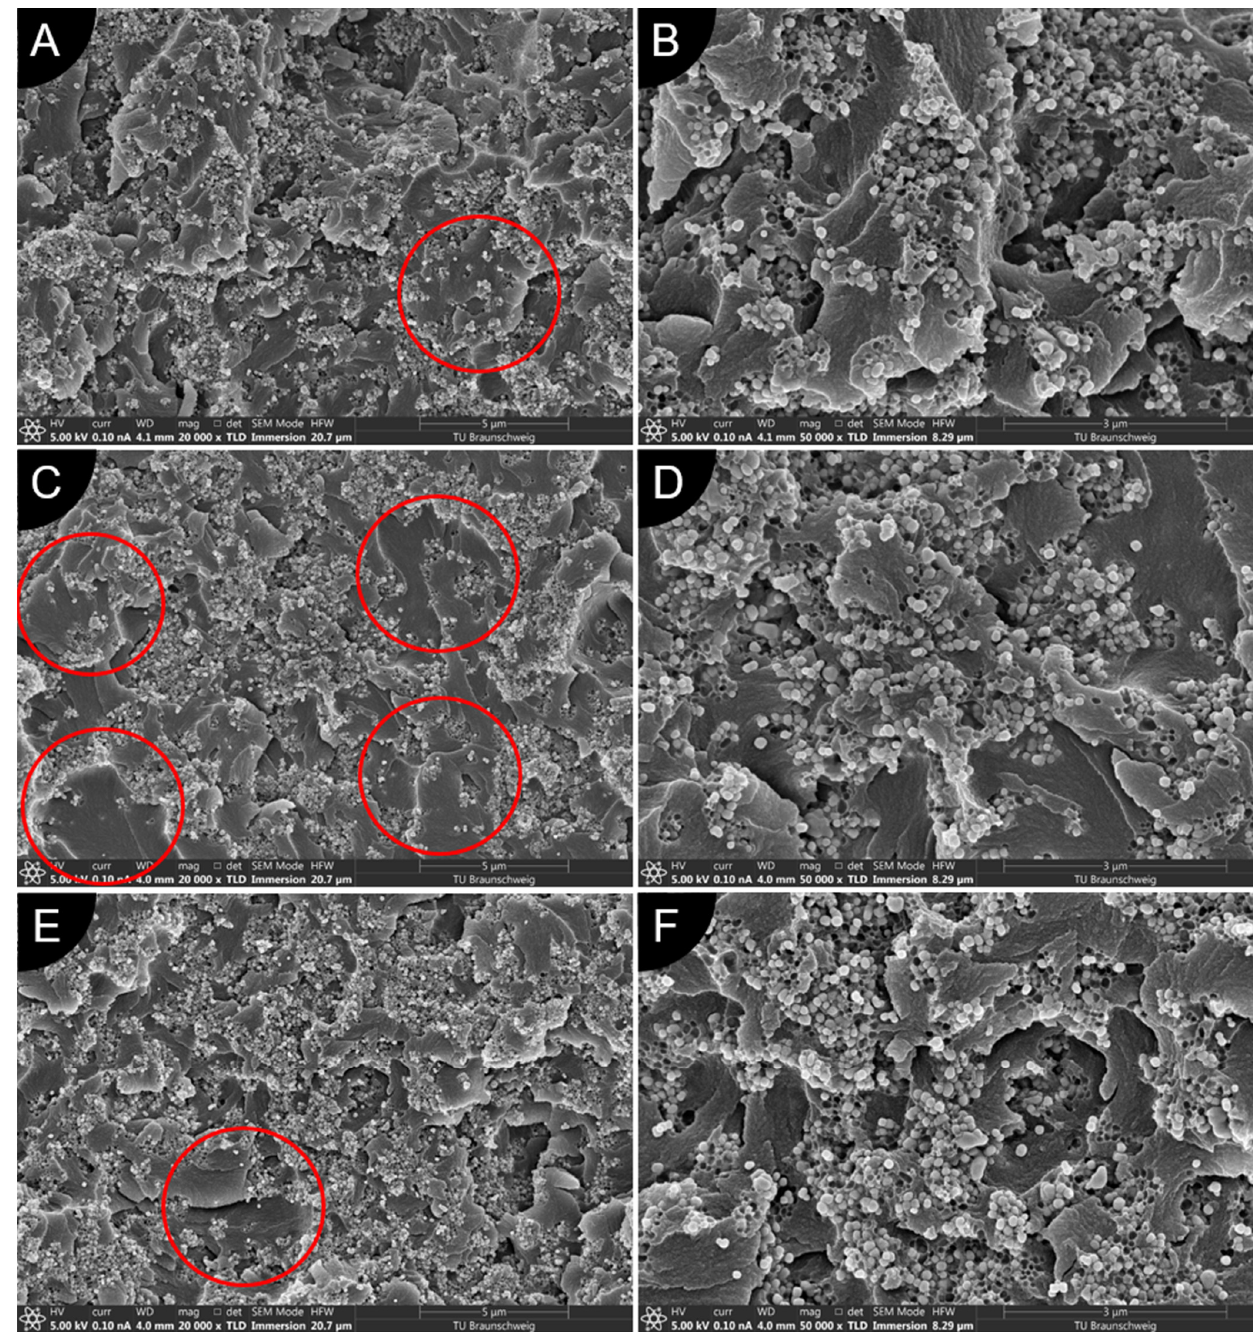
Figure 5. SEM images of cross-sections of solidified 10 vol.% BTO/photopolymer suspensions dis- persed with different solvents: ( A ) acetone (mag. ×20,000); (B) acetone (mag. ×50,000); ( C ) isopropyl alcohol (mag. ×20,000); ( D ) isopropyl alcohol (mag. ×50,000); ( E ) ethanol (mag. ×20,000); ( F ) ethanol (mag. ×50,000). Red circles show areas without particles.